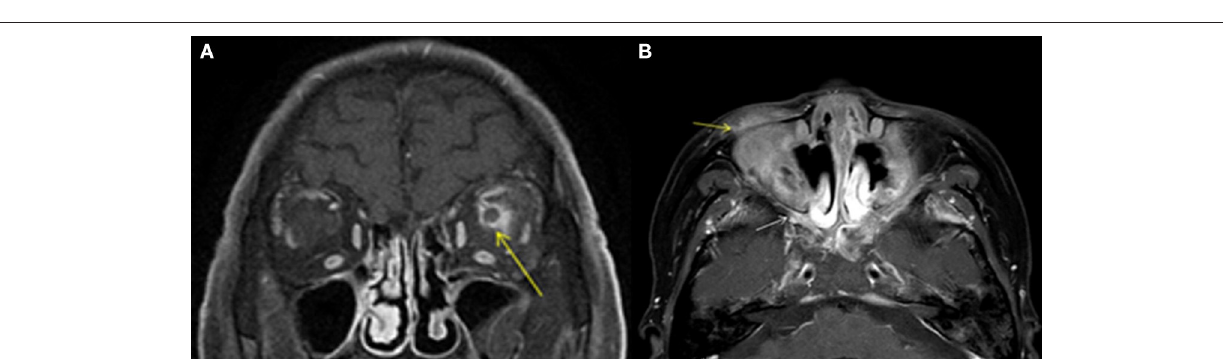
FIGURE 4 | MRI findings of OPN patients with GAP. (A) Coronal contrast enhanced T1-weighted MRI showing thickening and enhancement of the left optic nerve sheath (arrow). (B) Axial contrast enhanced T1-weighted MRI showing abnormal contrast enhancement shadow in the bilateral pterygopalatine fossa (white arrow) and inflammatory infiltration in the eyelid (yellow